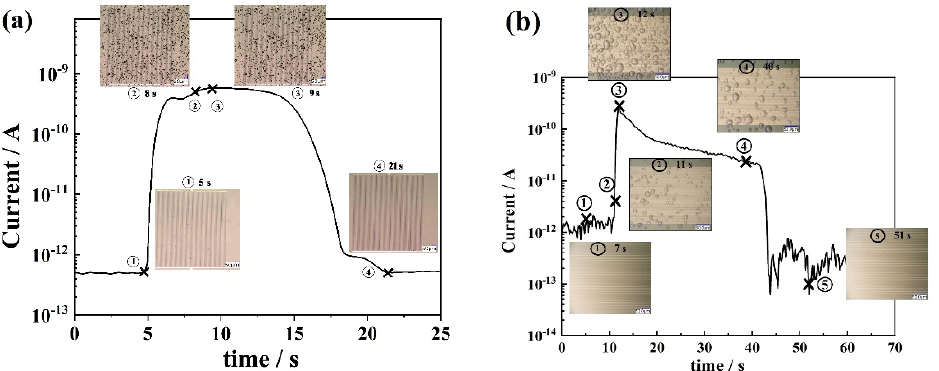
Figure 3. Current response on introduction of water droplets onto the sensor surface with time, and the corresponding microscopic images of the sensor surface at 1 (cid:79) 5 s, 2 (cid:79) 8 s, 3 (cid:79) 9 s and 4 (cid:79) 21 s of spraying in the case of figure ( a ) and at 1 (cid:79) 7 s, 2 (cid:79) 11 s, 3 (cid:79) 12 s, 4 (cid:79) 40 s and 5 (cid:79) 51 s of spraying in the case of figure ( b